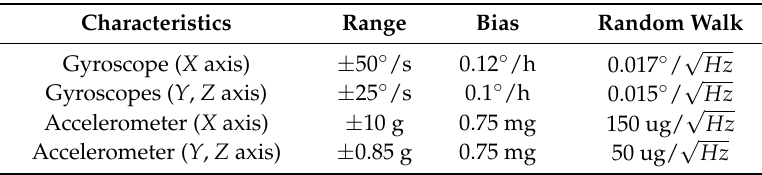
Table 8. Characteristics of IMU in the optimized Semi-Strapdown Inertial Navigation System (SSINS).